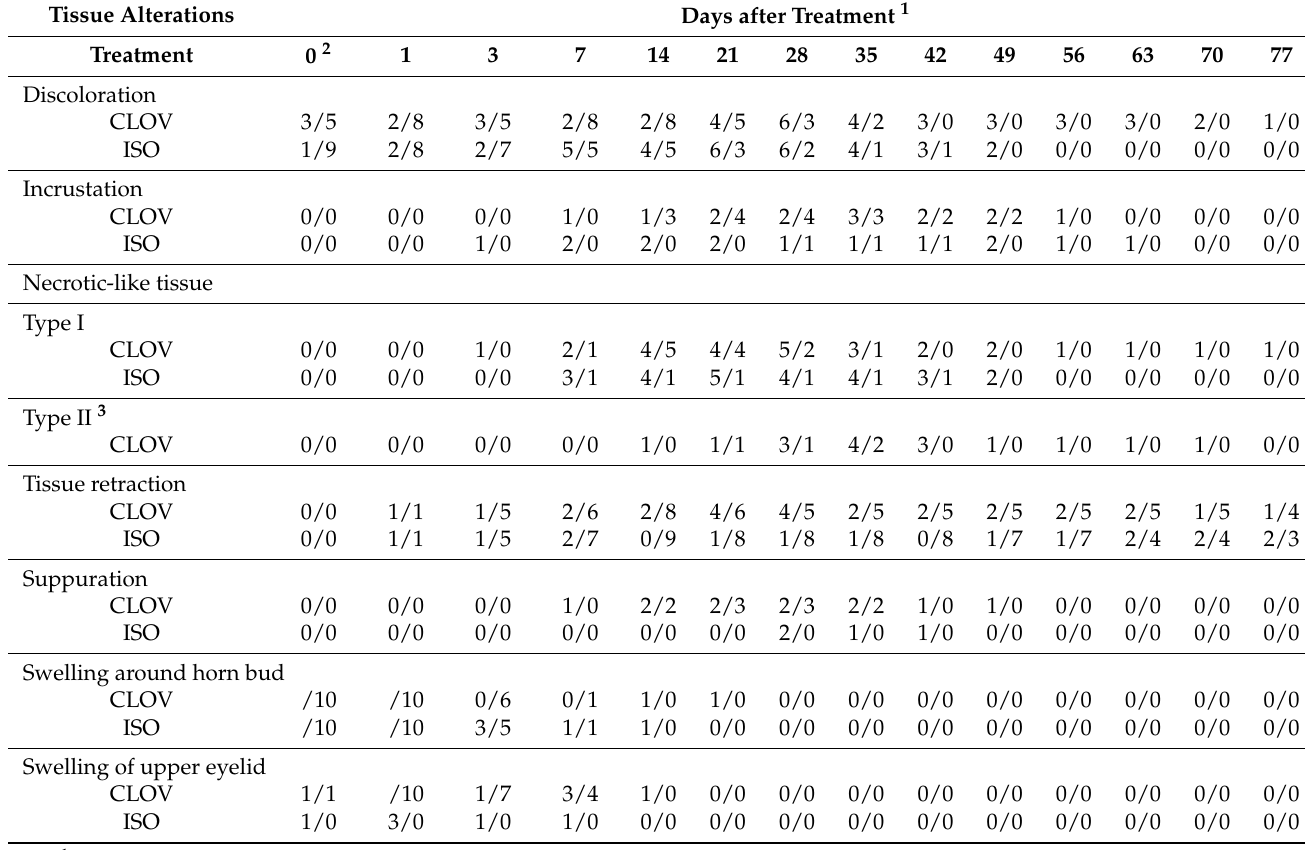
Table 2. Prevalence of tissue alterations observed after injection of clove oil (CLOV) or isoeugenol (ISO) under the horn buds until week 11. Numbers of calves with the respective tissue alterations on one or both sides of the head (one/both) are presented. For detailed definitions, see Supplementary Table S1. No tissue alterations were observed after injection of saline. Wounds of calves disbudded with a hot iron are not presented due to a different type of tissue alteration (exclusively incrustations and swellings around the horn